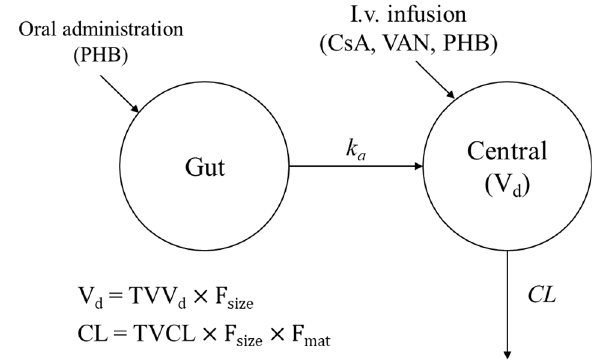
Figure 1. Pharmacokinetic model scheme for cyclosporine A (CsA), Vancomycin (VAN; Intravenous (i.v.) infusion) and phenobarbital (PHB; Oral administration and i.v. infusion).